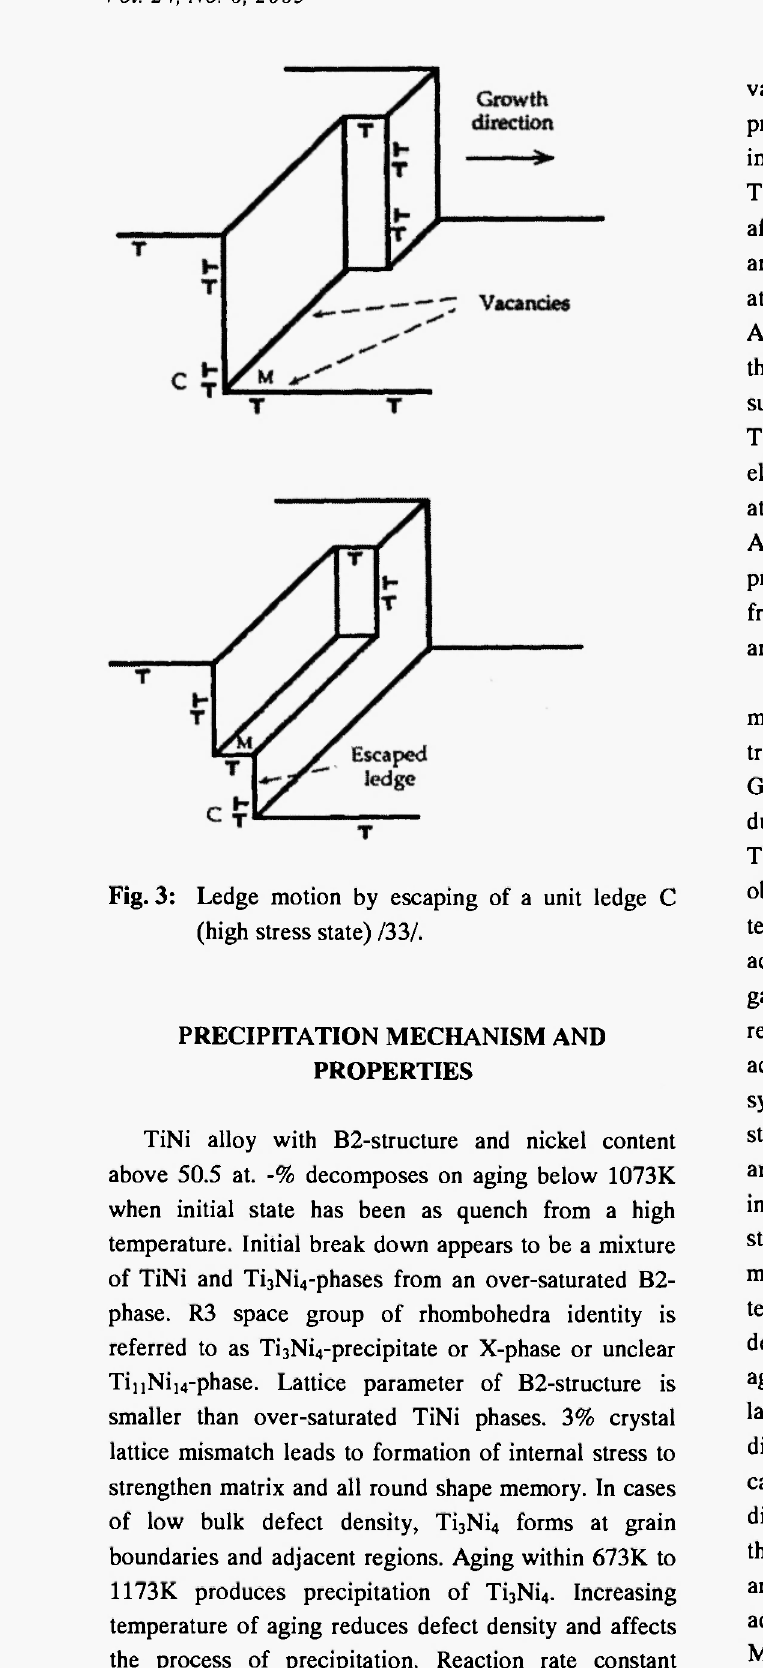
Fig. 3: Ledge motion by escaping of a unit ledge C (high stress state)